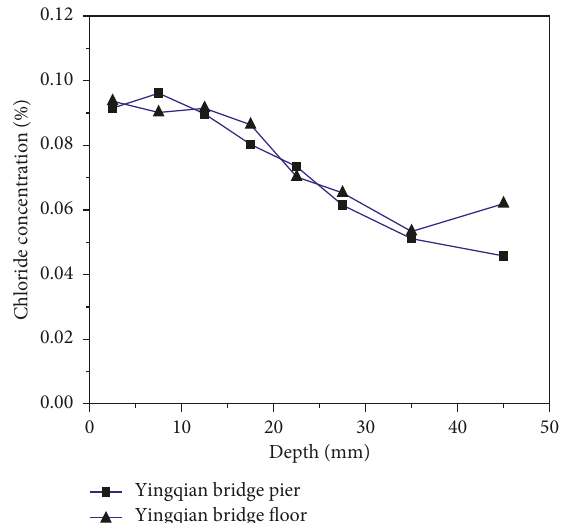
Figure 12: Comparison of chloride profile between two different bridges.